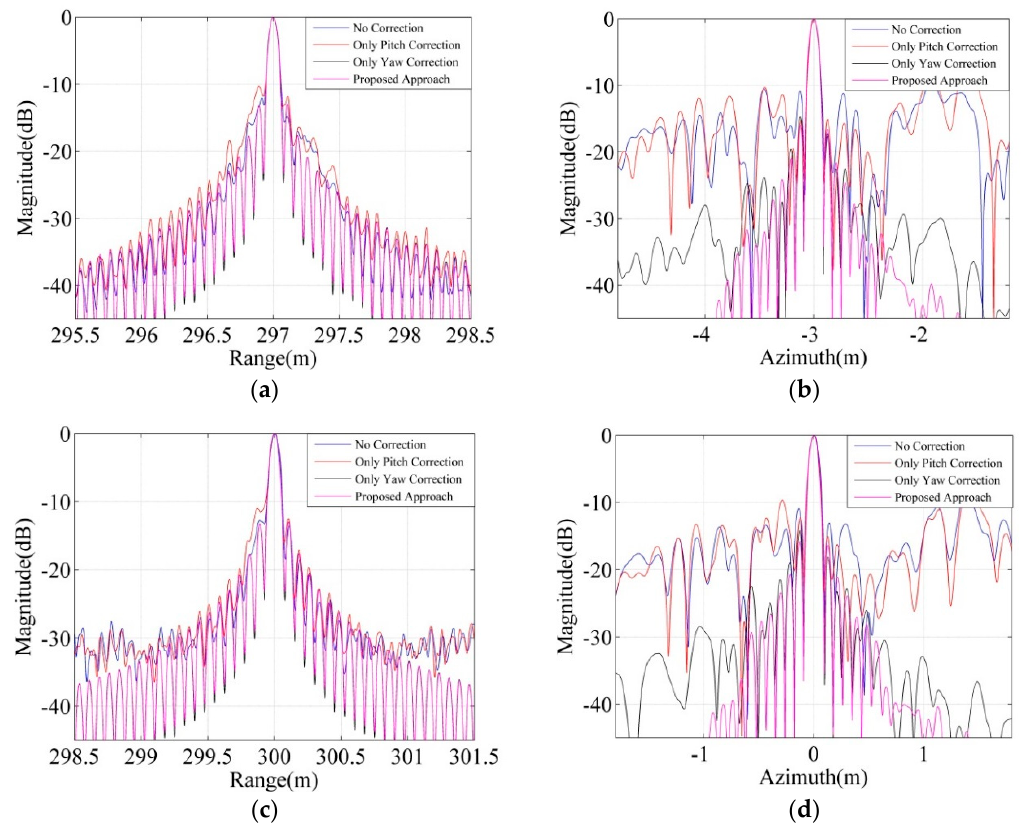
Figure 7. The magnitude of the azimuth slice and range slice for the point P 1 and P 5 in the case of the constant yaw angle and pitch angle. ( a ) The range slice of the point P 1 ; ( b ) The azimuth slice of the point P 1 ; ( c ) The range slice of the point P 5 ; ( d ) The azimuth slice of the point P 5 .